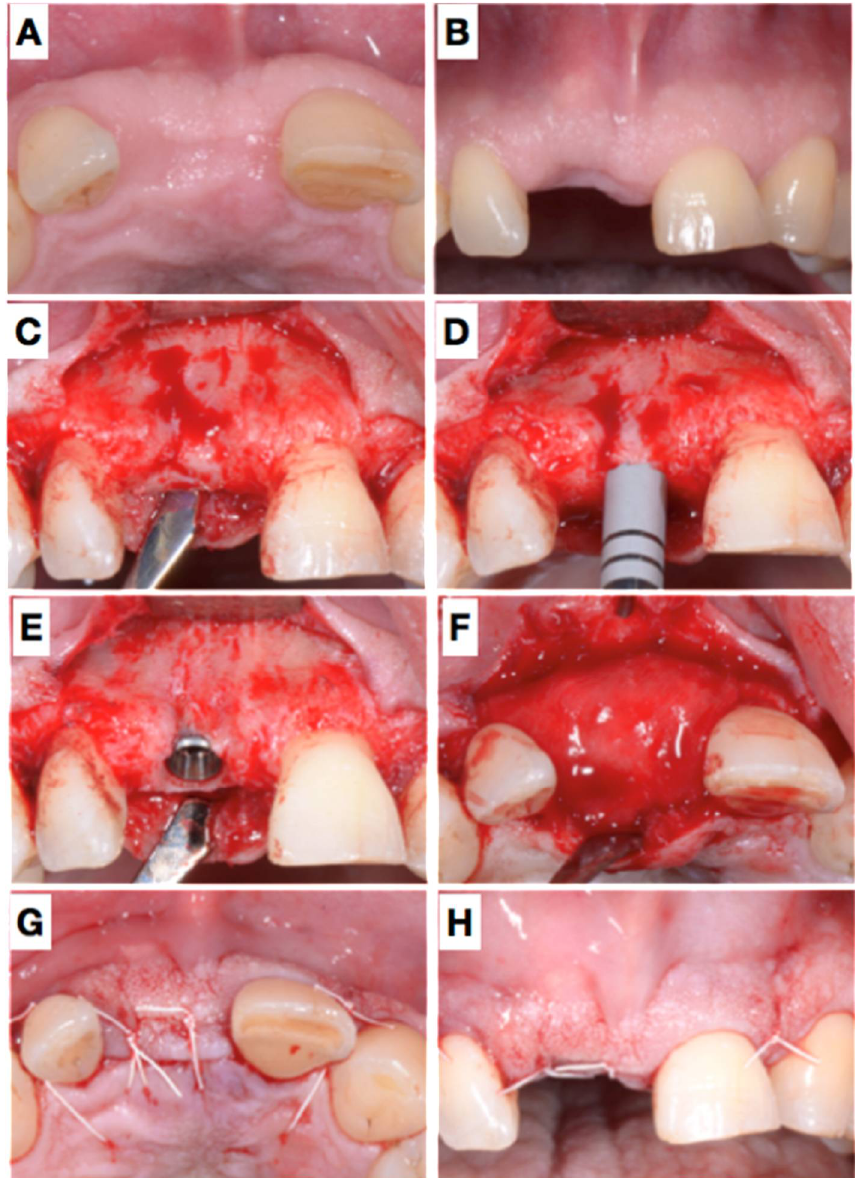
Figure 3. Clinical situation before implant placement, 7 months after extraction ( A , B ). Panel ( C ) shows the situation after elevation of a flap and ( D ) elucidated the biopsy. Afterwards, an implant could be placed in an ideal position ( E ): A thin buccal bone coverage was achieved also at the buccal site. Nevertheless, a little GBR was performed using a filler material and a resorbable collagen membrane ( F ); wound closure ( G , H ).